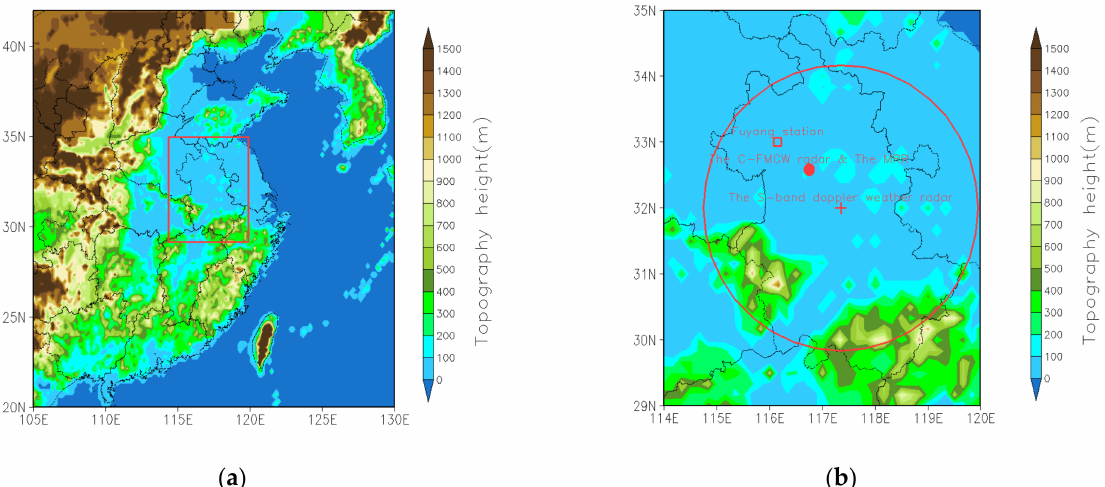
Figure 1. ( a ) Eastern China topography (color shading represents elevation, red box shows study area). ( b ) The locations of three radars and Fuyang station in the study area (red circle represents the S-band Doppler weather radar coverage; red cross symbol represents the S-band Doppler weather radar; red dot symbol represents the C-FMCW radar and the MRR; red box symbol represents Fuyang station). Table 1. Main parameters of the S-band Doppler weather radar, the C-FMCW radar, and MRR. Radar